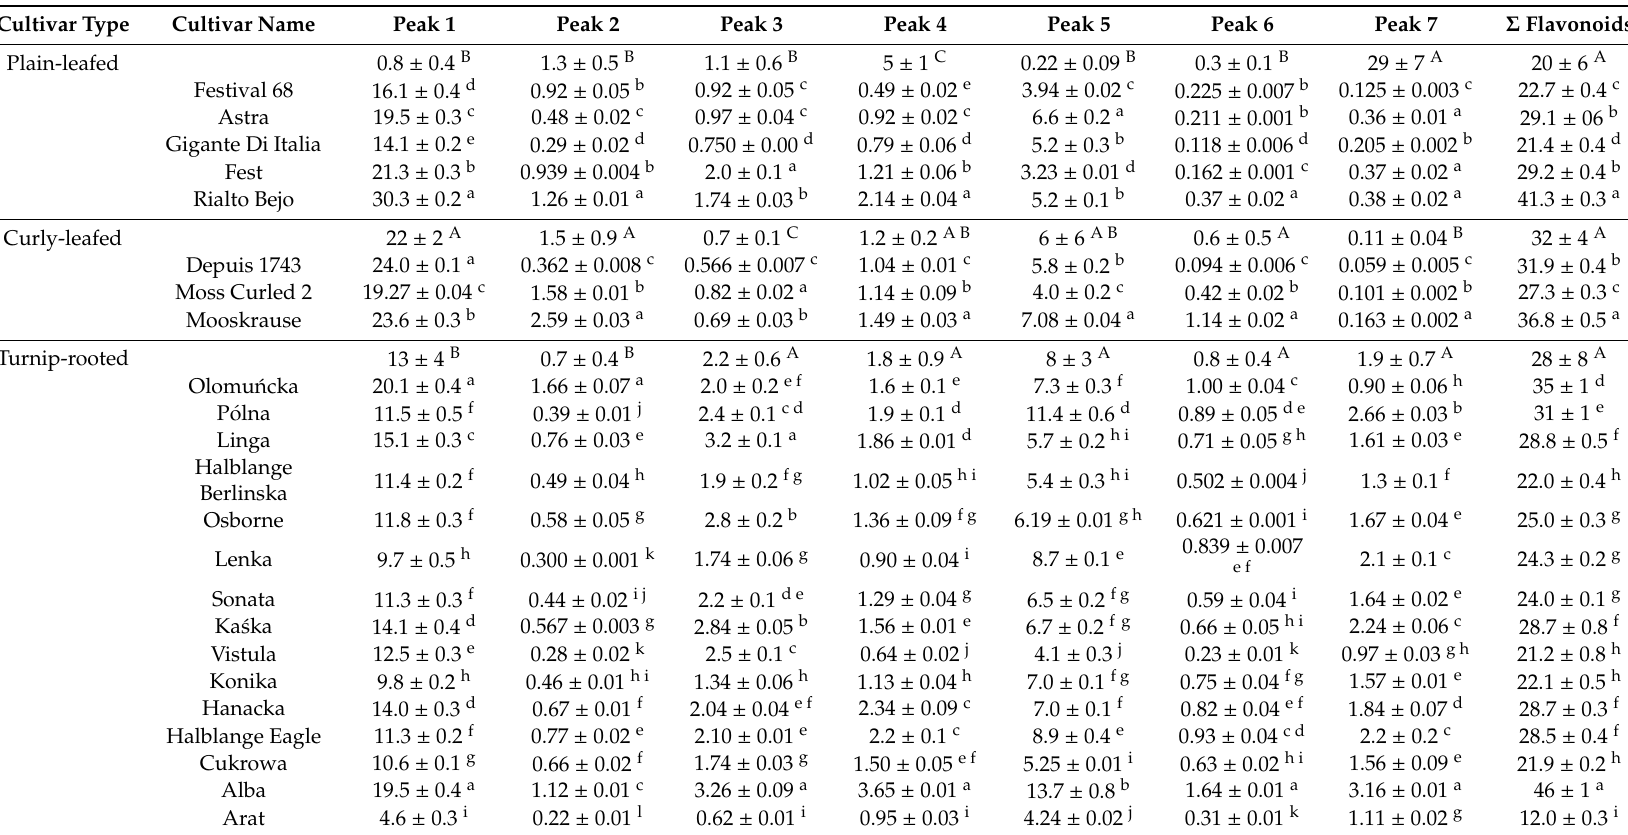
Table 2. Quantification (mg / g of extract) of the phenolic compounds present in the hydroethanolic extracts of the tested parsley leaves (mean ± SD, n = 3). Cultivar Type